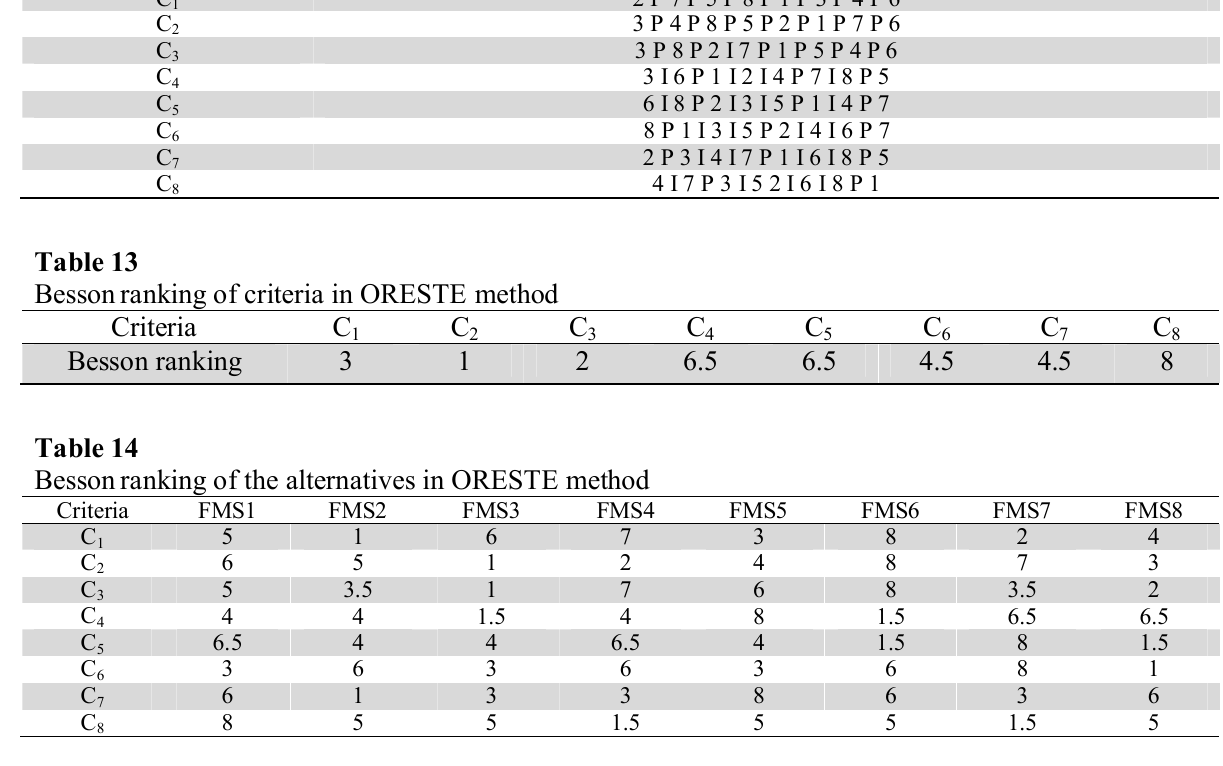
Weak order of the alternatives for each criterion in ORESTE method Criteria